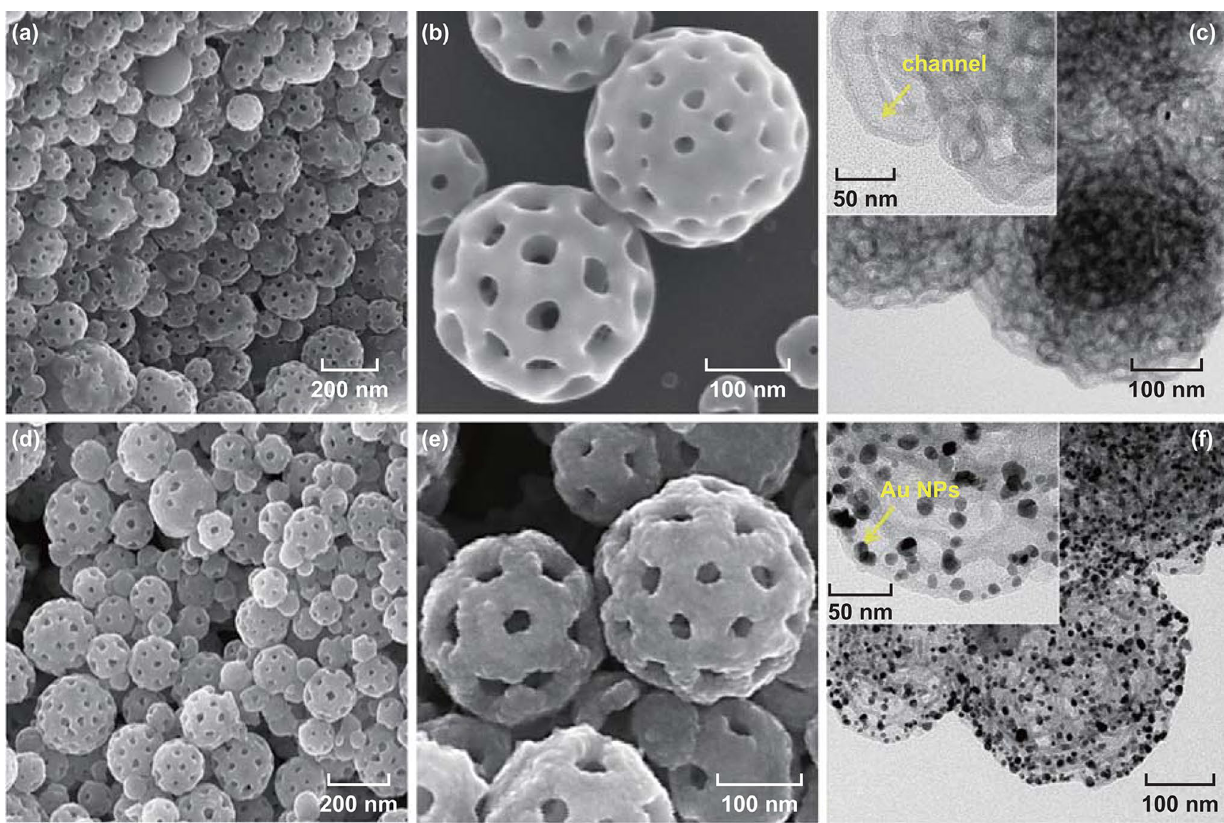
Fig. 2 a , b SEM and c TEM images of the PDA porous particles. d , e SEM and f TEM images of the Au@PDA particles. Insets are the enlarged parts of the